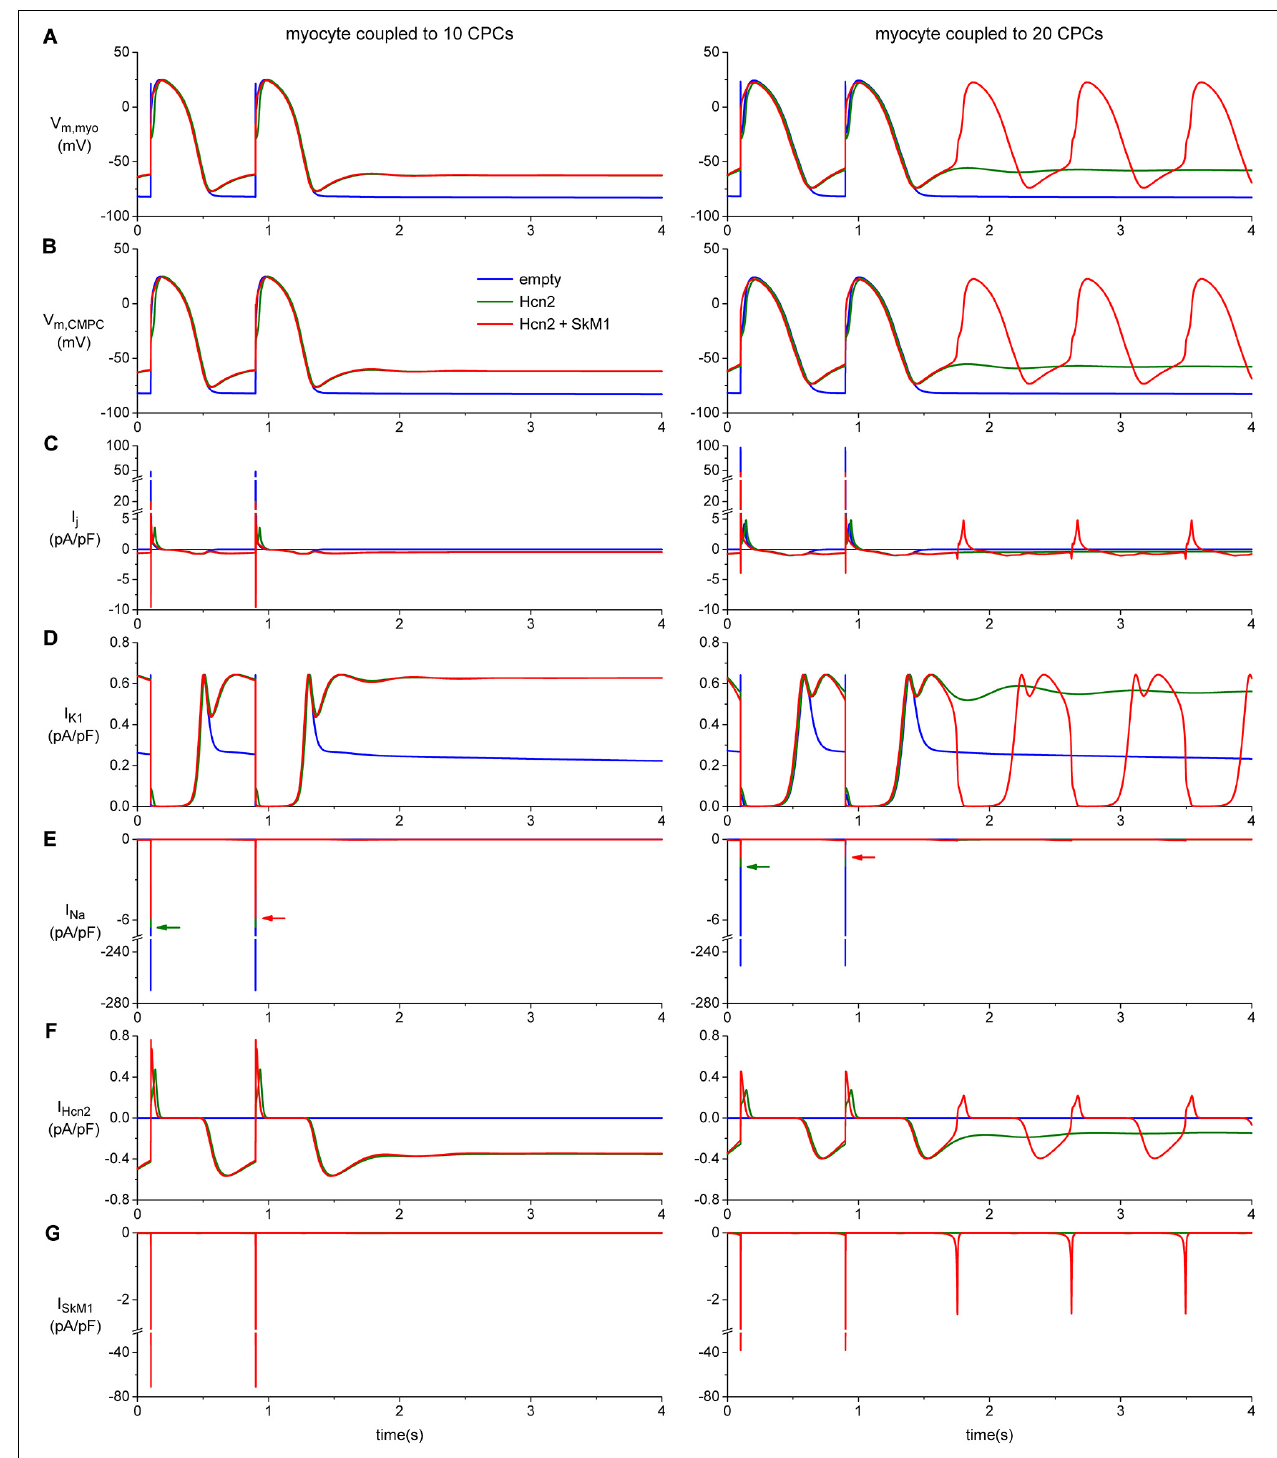
FIGURE 8 | Computer simulation of action potentials of a human ventricular myocyte coupled to 10 (left panels) or 20 CPCs (right panels) overexpressing Hcn2 alone (green line), or Hcn2 + SkM1 (red line). The blue line shows the action potentials of the myocyte coupled to 10 (left) or 20 (right) empty CPCs. (A) Last two action potentials of a train of 100, induced by a 1 ms, ≈ 50% suprathreshold stimulus. Formation of stable pacemaker function after ending the train of stimuli is found only with the larger number of CPCs and only in the Hcn2 + SkM1 group and not in the simulation with Hcn2 alone. (B) Corresponding membrane potential of each of the CPCs. (C) Total junctional current flowing from the myocyte to the CPCs. Positive junctional current is outward for the myocyte, but inward for the CMPCs, and vice versa. (D,E) Membrane ion currents I K1 and I Na of the myocyte. (F,G) Membrane ion currents I Hcn2 and I SkM1 of each of the CPCs.